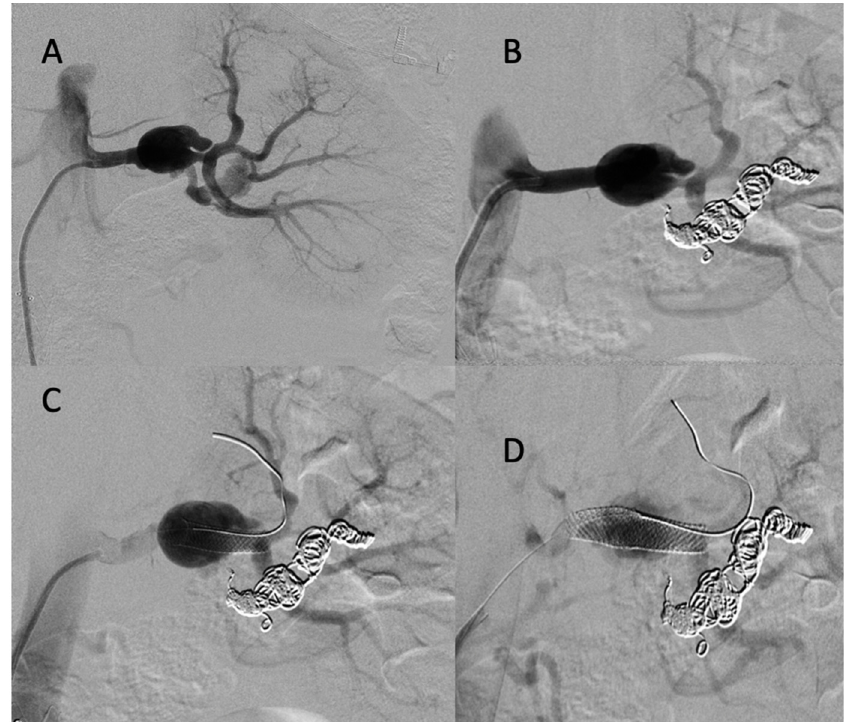
Figure 9. ( A ) Digitally subtracted image from the left renal artery dissection with aneurysm formation; ( B ) postembolization of the left retropyelic artery by multiple coils and a small amount of ethylene vinyl alcohol copolymer; ( C , D ) post-deployment of a two carotid wall stent in the left prepyelic artery.